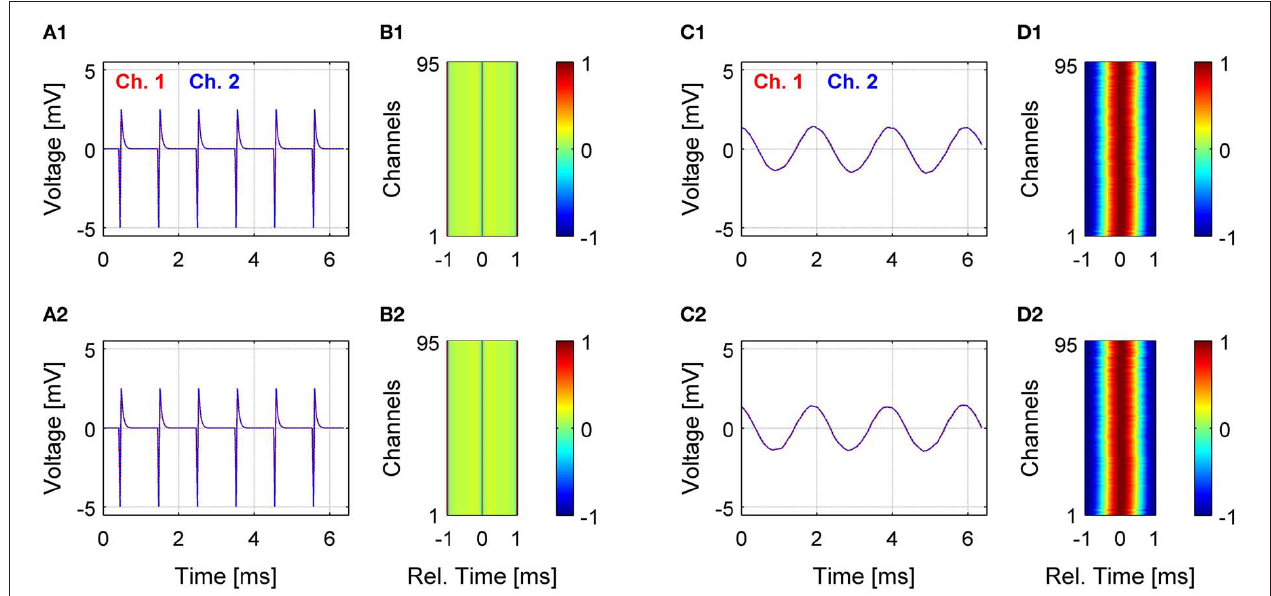
FIGURE 5 | Reliability of data acquisition over extended recording times. The reliability of the system to acquire samples with precise timing was tested on two levels, only including the digital DAQ card (A,B) and with an electrode and the digital headstage connected to the digital card (C,D) . In the former case, a repeating pattern was created digitally, in the latter case, a 500Hz sinusoudal voltage signal was injected into the bath with the electrode. All recordings were performed at 31.25kHz on 96 channels for 1h of recording time. The top row shows results after a few seconds of acquisition, and the bottom row shows the same channels after an hour of